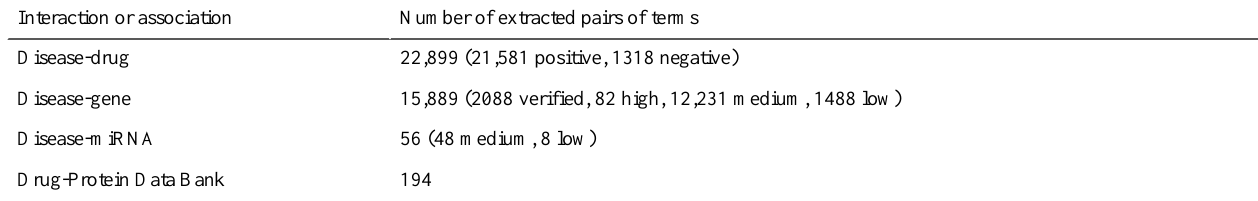
Table 1. Pairs of terms as identified in the analyzed set of documents a .